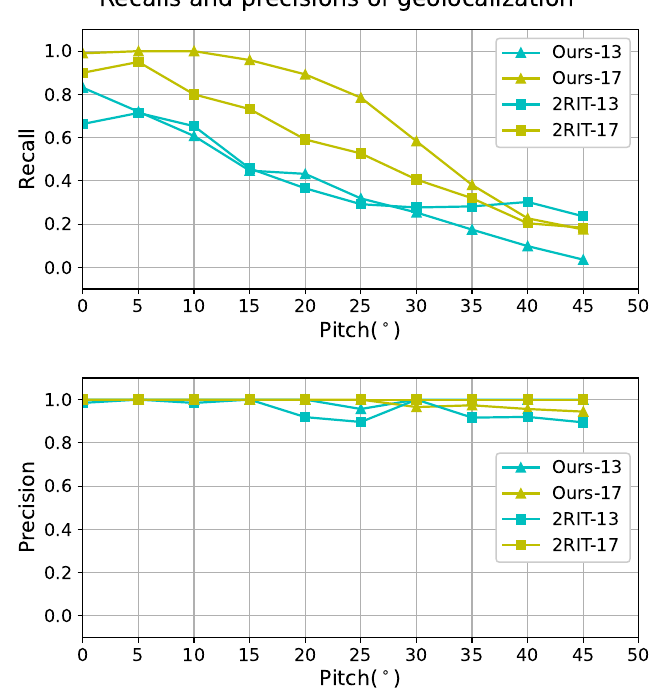
Figure 6. Precision and recall of geolocalization under different viewing angles of the “2-road- intersections-tuple” (2RIT) method [5] and our